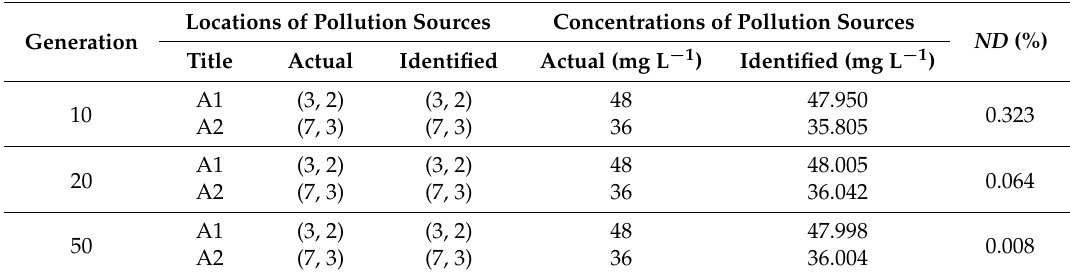
Table 7. Effect of variation in generation